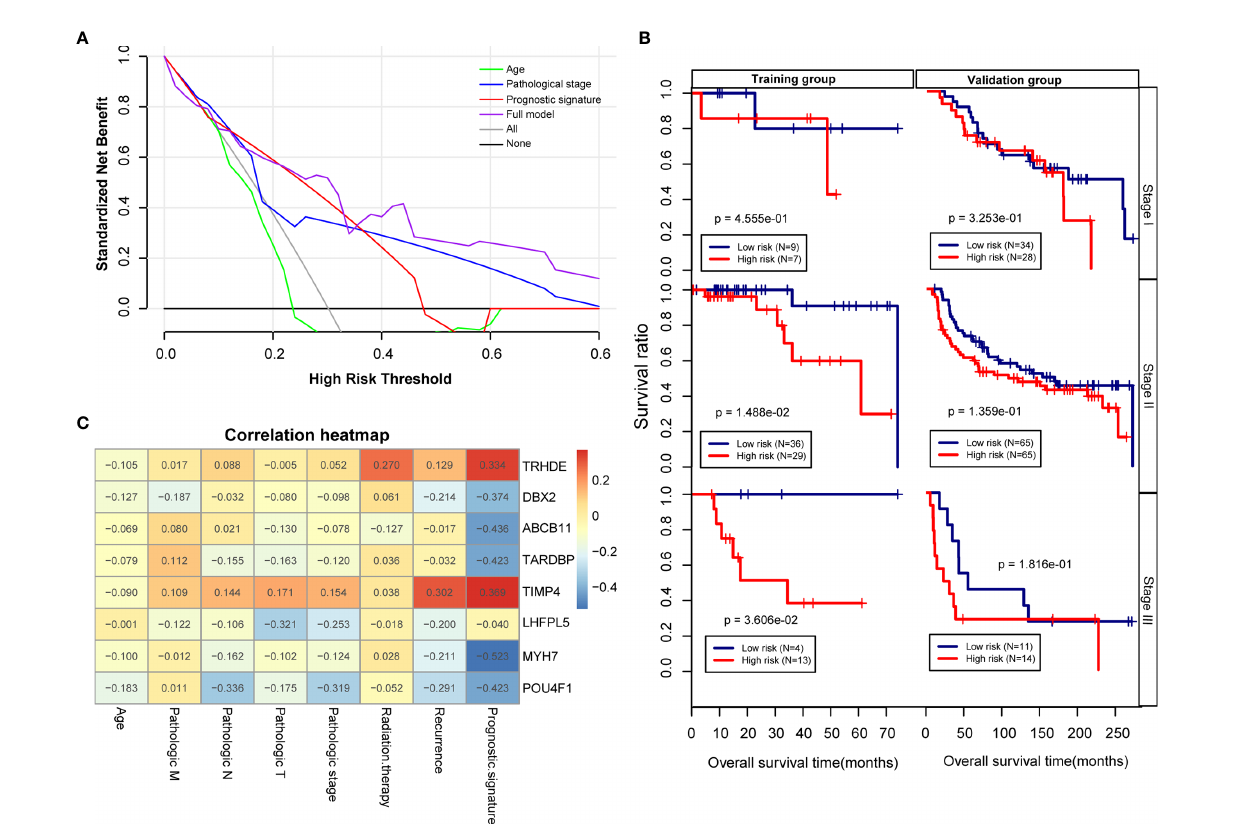
FIGURE 6 | Effectiveness and comparison of the prognostic model. (A) Decision curve analysis. The green, blue, red and purple colours represent the decision curves for the patient ’ s age, pathological stage, PS model and combined model, respectively. The grey and black curves show the two extremes. (B) Kaplan-Meier curves were analysed by pathological stage strati fi cation in the TCGA training set and Metabric validation set. (C) Heat map depicting the signi fi cance of correlations between clinical characteristics and 8